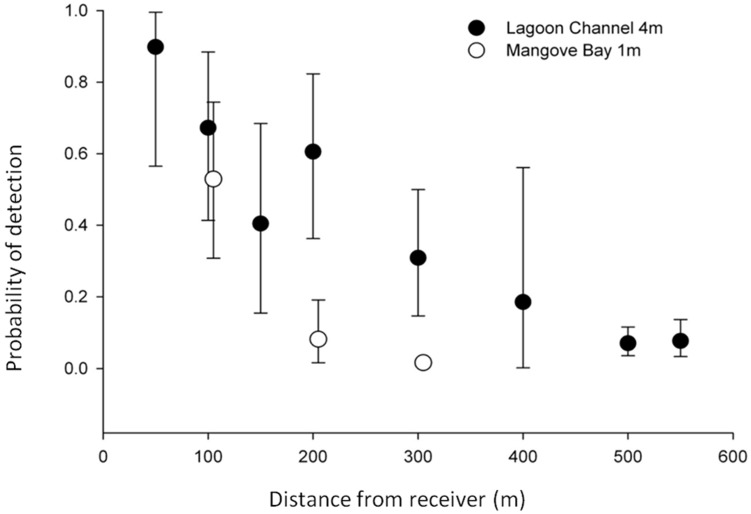
Mangrove Bay array range testing.Proportion of detections received by VR2 receivers at increasing distances from the test transmitter in the lagoon channel (filled circles, 4.0 m water depth) and at Mangrove Bay (white circles, 1.0 m water depth).